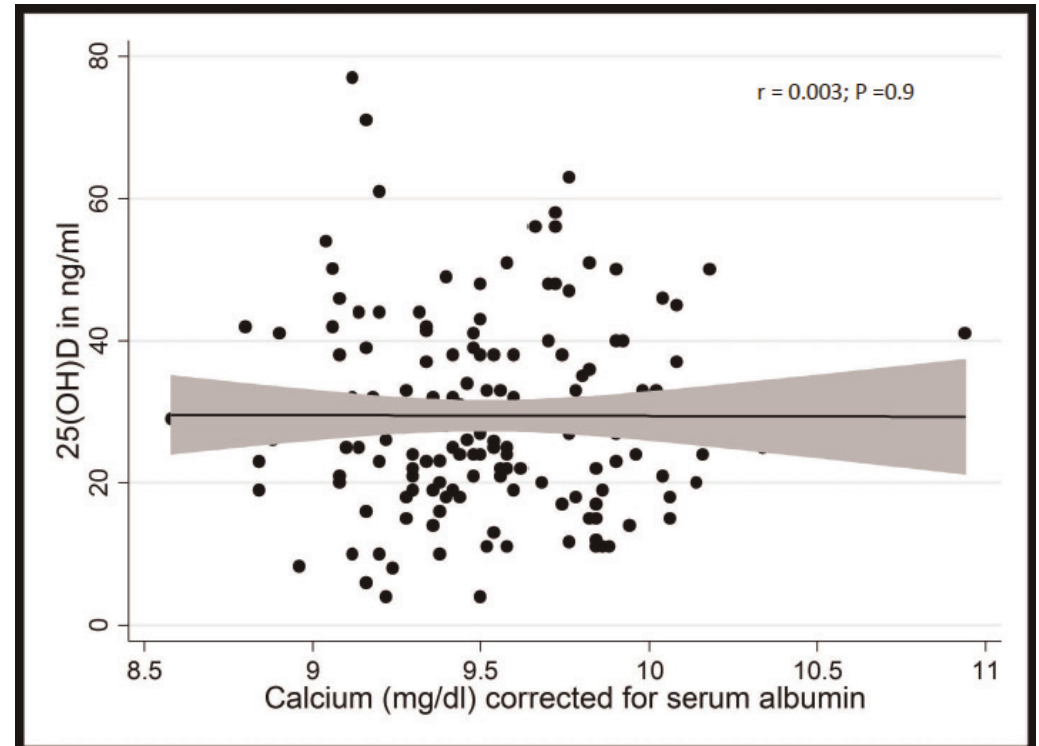
Figure 1. Scatterplot of corrected serum calcium levels by 25-hydroxyvitamin D [25(OH)D] levels in the total group of patient participants with cirrhosis (n =